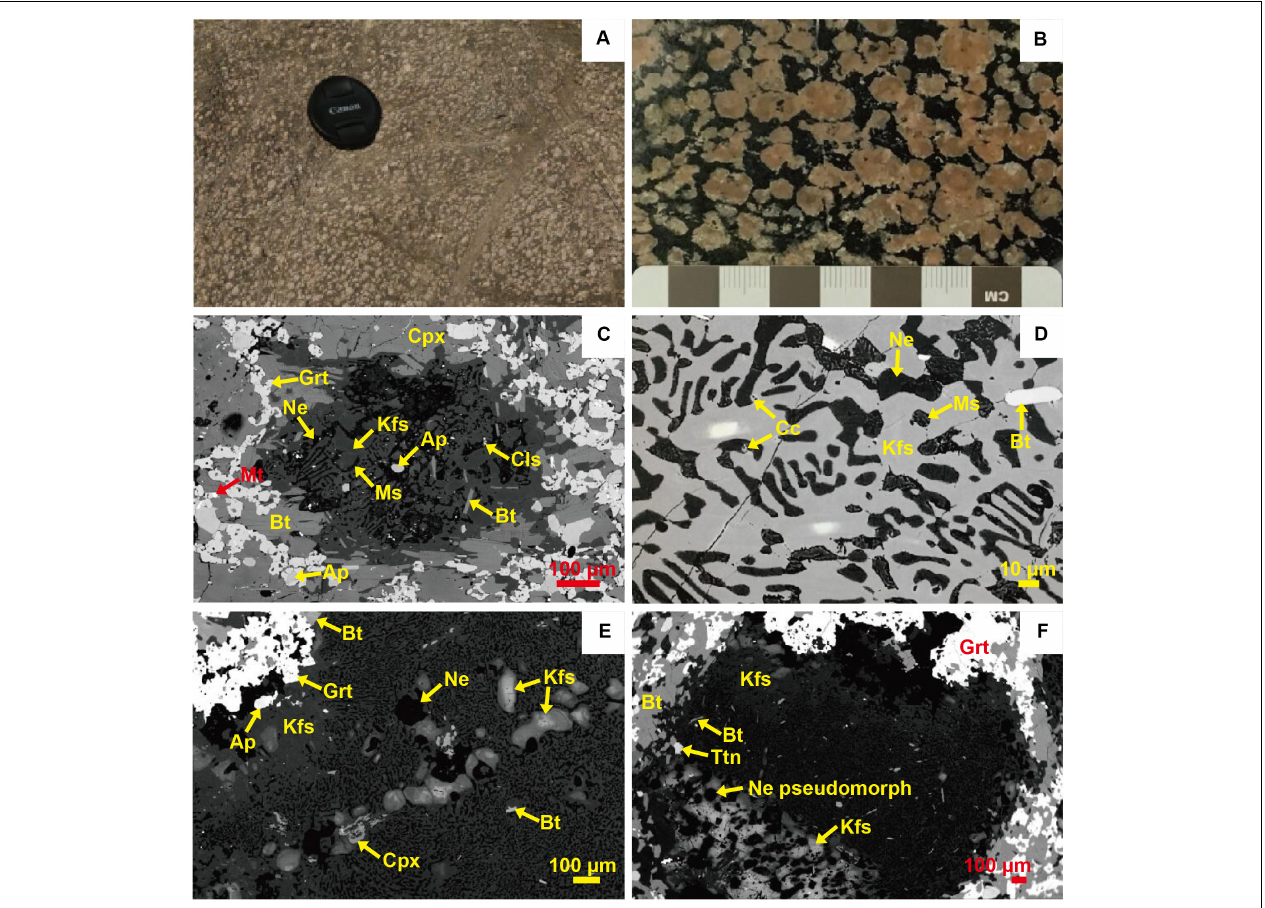
FIGURE 4 | Photos of pseudoleucite clinopyroxenite. (A) Field photo. (B) A polished hand specimen. (C) A representative pseudoleucite and the mineral phases in both of the pseudoleucite and the matrix (BSE image). (D) Vermicular intergrowth of K-feldspar, nepheline and muscovite (BSE image). (E) Compositionally zoned K-feldspars clusters in a lineation (BSE image). (F) Coarse nepheline pseudomorphs in the compositionally zoned K-feldspars (BSE image). Cc, Calcite; Cls, Celestine; Grt, garnet; Ms, Muscovite; Ne, Nepheline; others are as